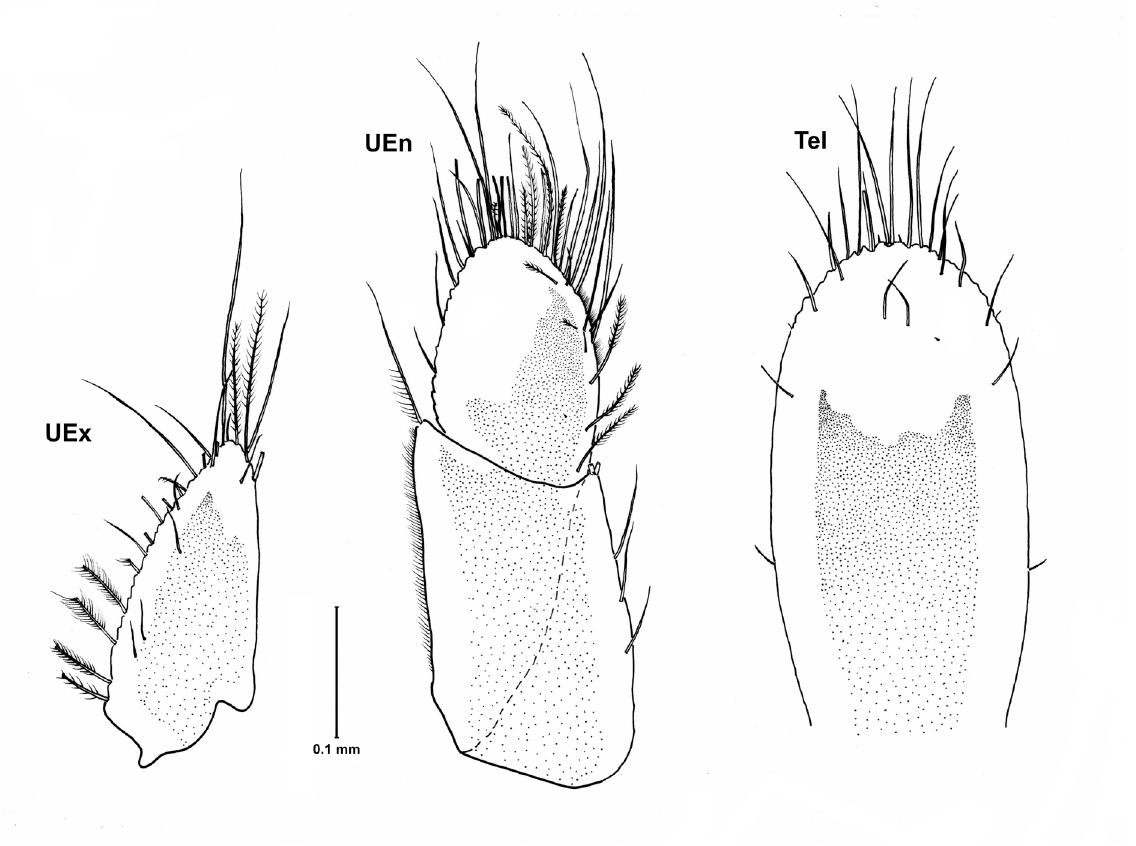
Fig. 30. Colanthura gerungi sp. nov. , ♂, holotype (MZB Iso 109). Abbreviations: UEx = exopod of uropod; UEn = endopod of uropod; Tel =